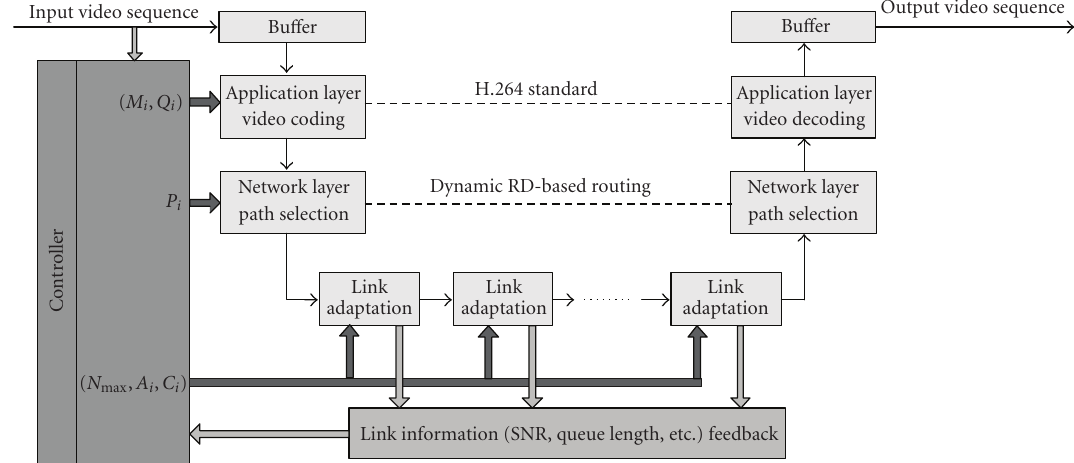
Figure 2: An integrated cross-layer framework of multimedia communications over multihop wireless networks.